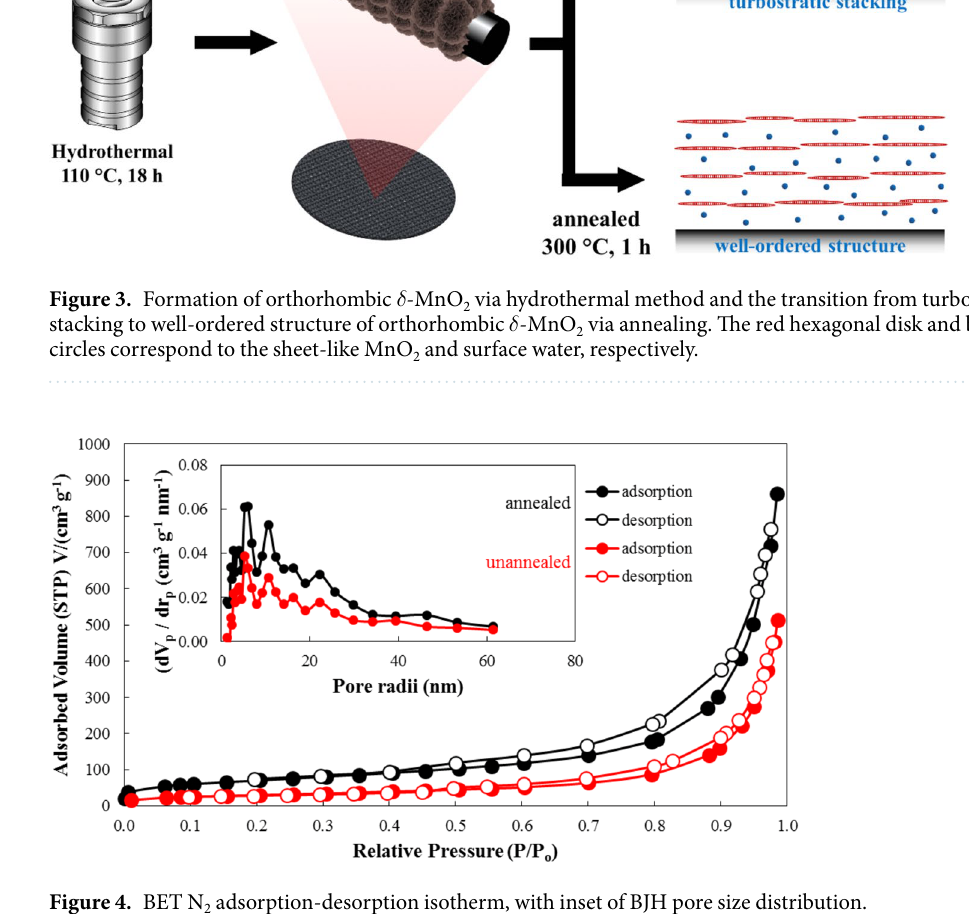
Figure 4. BET N 2 adsorption-desorption isotherm, with inset of BJH pore size